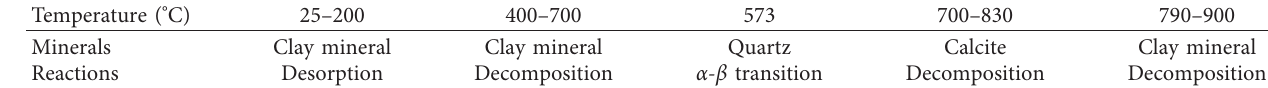
Table 1: Thermal reactions in rocks